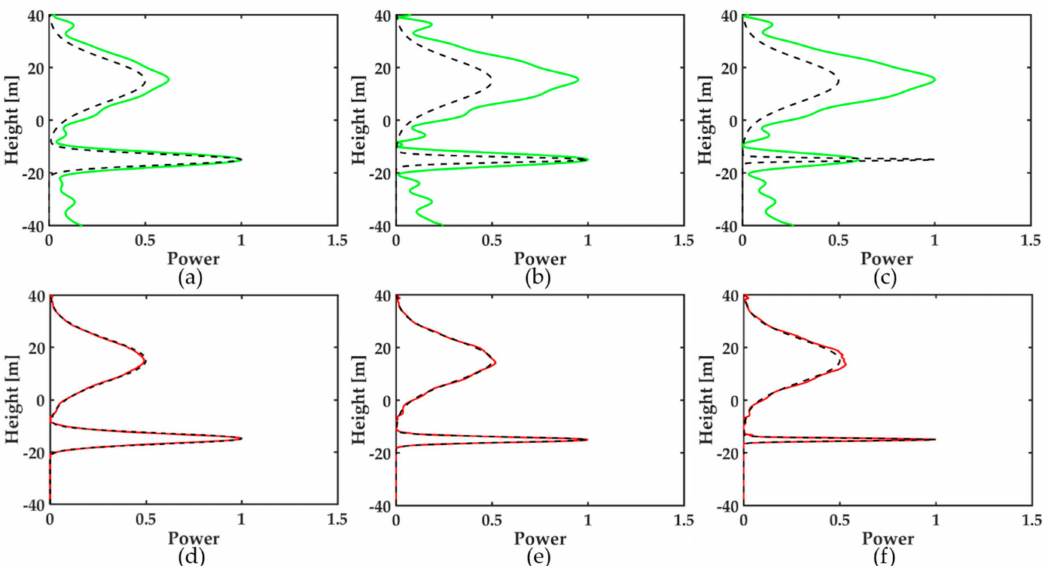
Figure 4. The reconstructed reflectivity profiles by the W&O-CS and W&O-SPICE TomoSAR methods for a simulated signal with di ff erent ground angular spreading values with the same forest scattering scenario (r > 1): ( a ) W&O-CS for the wide ground angular spreading; ( b ) W&O-CS for the moderate ground angular spreading; ( c ) W&O-CS for the narrow ground angular spreading; ( d ) W&O-SPICE for the wide ground angular spreading; ( e ) W&O-SPICE for the moderate ground angular spreading; ( f ) W&O-SPICE for the narrow ground angular spreading. The black dotted lines are the normalized simulated profiles. The blue solid lines are the reconstructed reflectivity profiles of wavelet-SPICE. The red solid lines are the reconstructed reflectivity profiles of